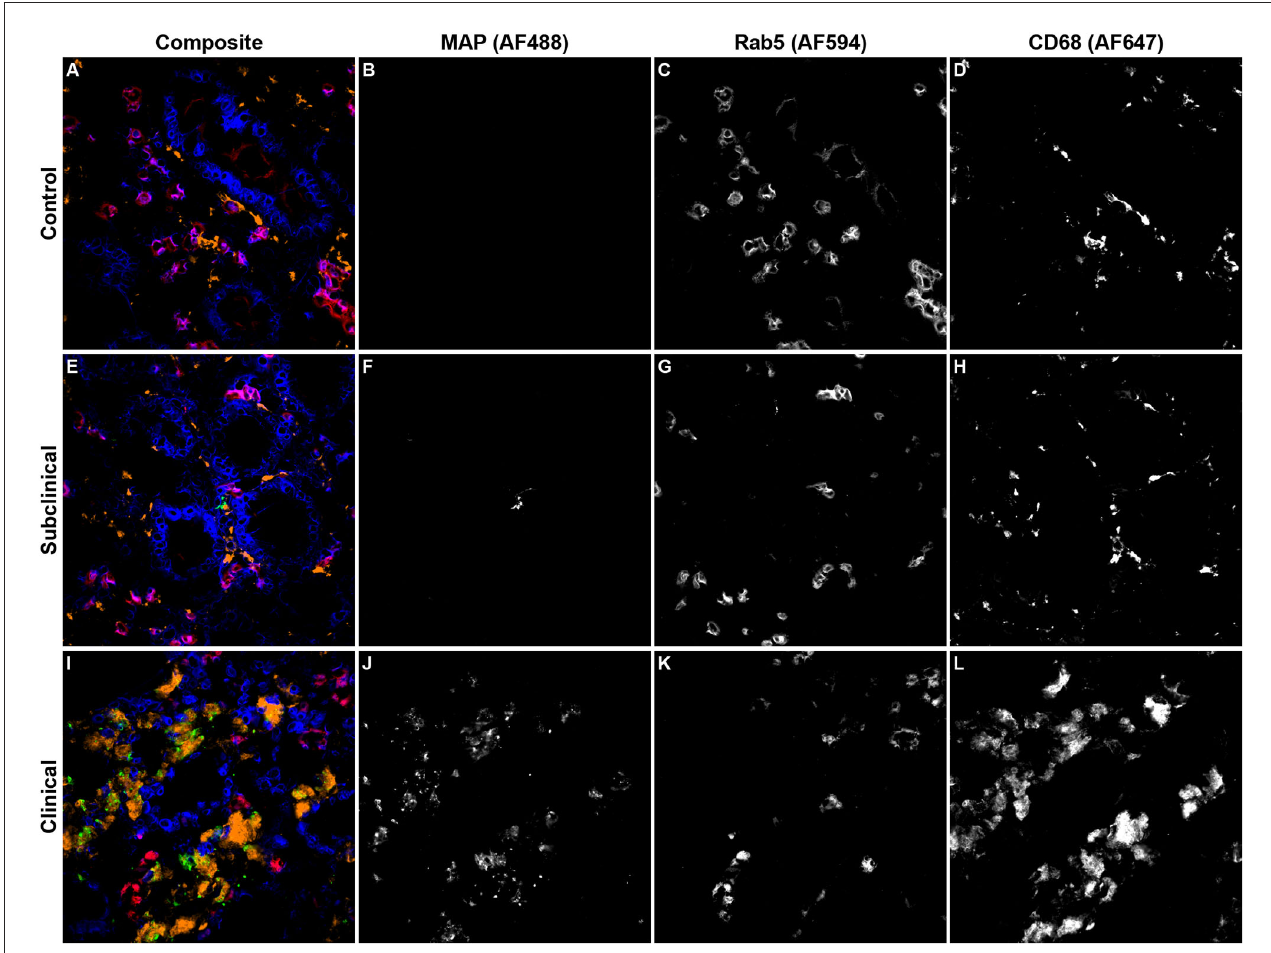
FIGURE4 Representative confocal microscopy images of frozen mid-ileum sections from JD- control cows (A–D) and cows in subclinical (E–H) or clinical (I–L) stages of paratuberculosis. Composite images overlaying each laser channel are presented in (A, E, I) . Mycobacterium avium subsp. paratuberculosis (MAP; green) labeling was detected using an AF488 secondary antibody and excited on the 488nm laser (B, F, J) , while Rab5 (red) primary antibody was directly conjugated to AF594 and excited on the 561nm laser (C, G, K) . CD68 (orange) was labeled with an AF647 secondary antibody and excited on the 641nm laser (D, H, L) . Counterstaining of nuclei (blue) was achieved using DAPI and was excited on the 405nm